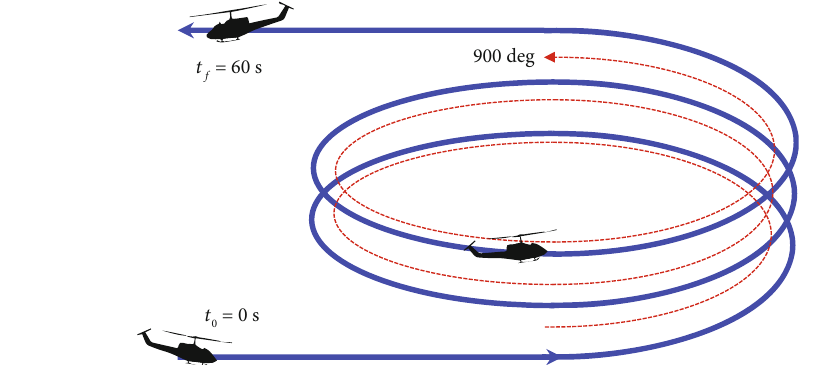
Figure 2: Helical turn